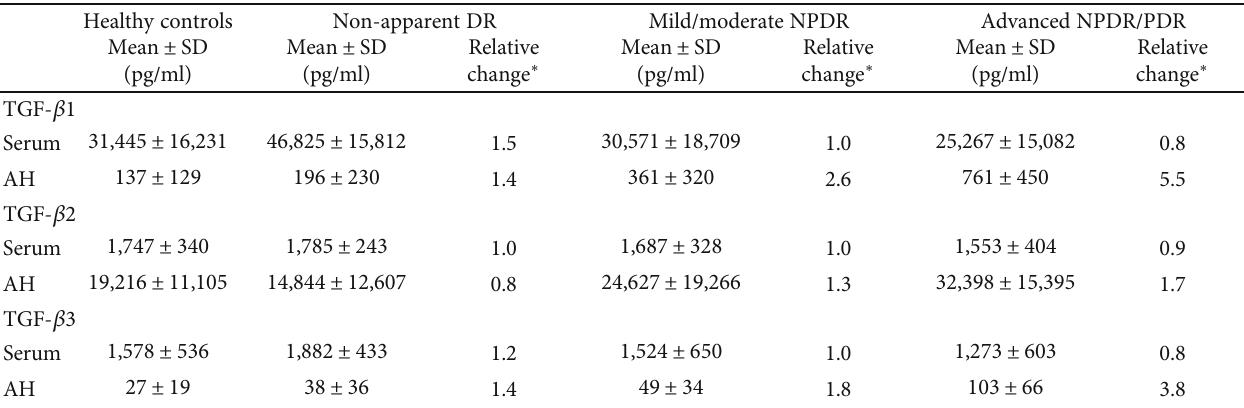
Table 2: Concentrations ( mean ± SD ; pg/ml) of TGF- β 1, TGF- β 2, and TGF- β 3 in serum and AH of healthy individuals (controls) and diabetic patients with di ff erent stages of DR. The fold change for each group was calculated relative to the control group. Healthy